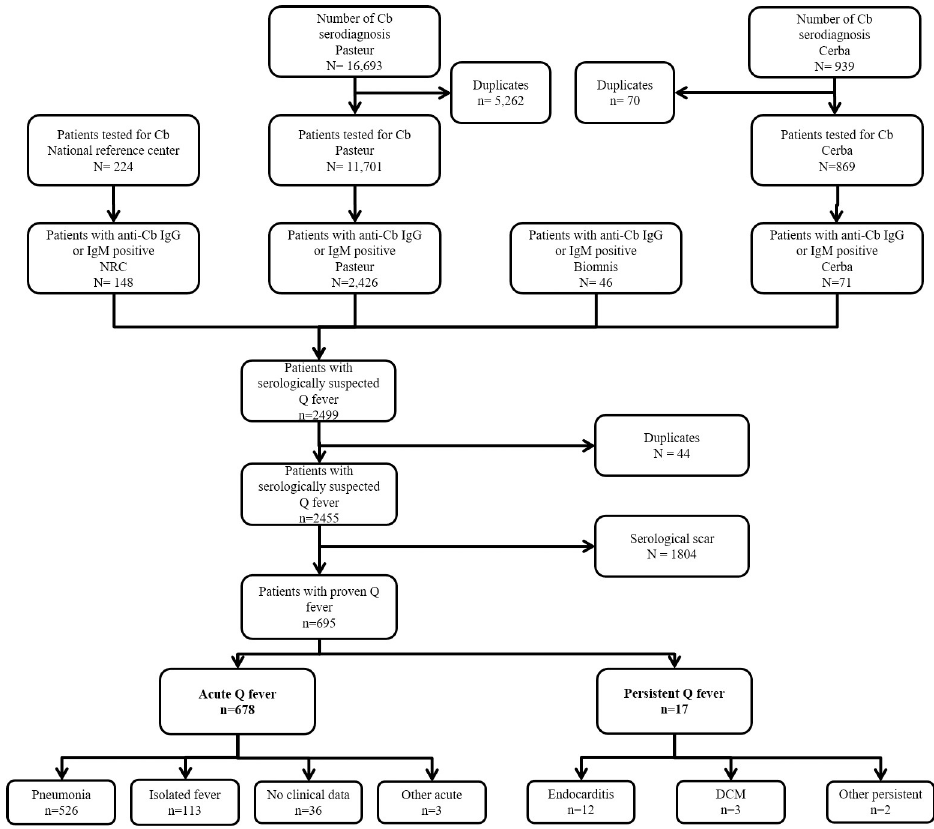
Fig 1. Flowchart of the study. Details of the cases of Q fever between 2007 and 2017. Cb = Coxiella burnetii ; QF = Q fever; DCM = Dilated cardiomyopathy. Other acute: 1 asymptomatic seroconversion in a women tested in the assessment of her husband’s family who had a symptomatic form; 1 acute meningitis, 1 acute myopericarditis. Other persistent: 1 infectious chronic polyarthritis; 1 granulomatous hepatitis in a patient with immunosuppressive treatment for rheumatoid arthritis.